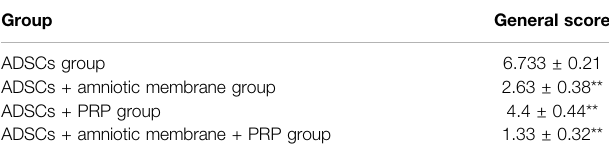
TABLE 1 | Wakitani score: gross score of articular cartilage at 12 weeks after operation. Group